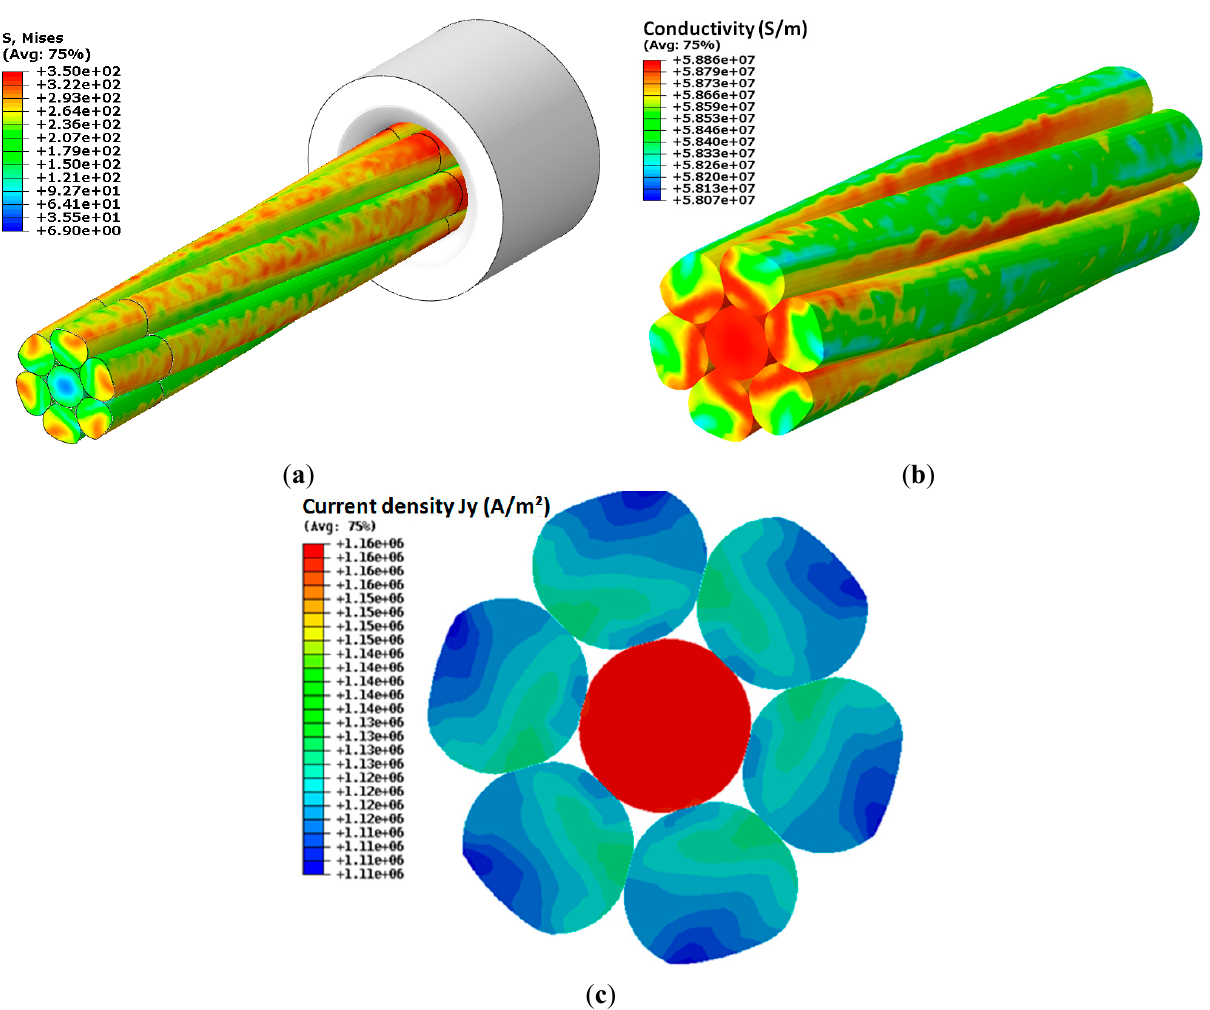
Figure 13. Distribution of residual stress ( a ); the resulting relative conductivity distribution (referred to the basic conductivity) ( b ) and resulting current density ( c